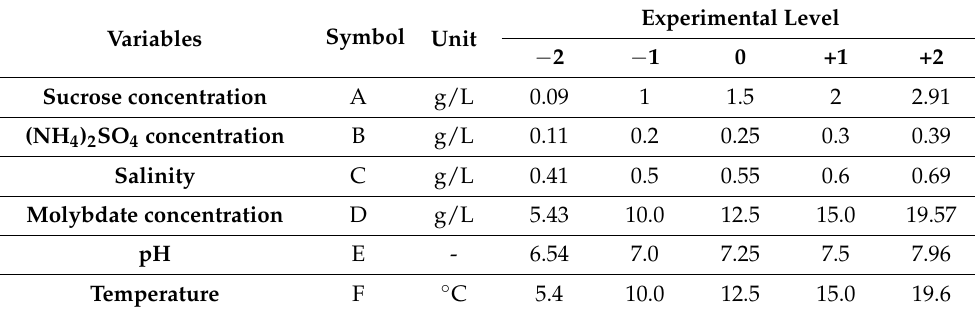
Table 1. Experimental range and level of independent variables tested in